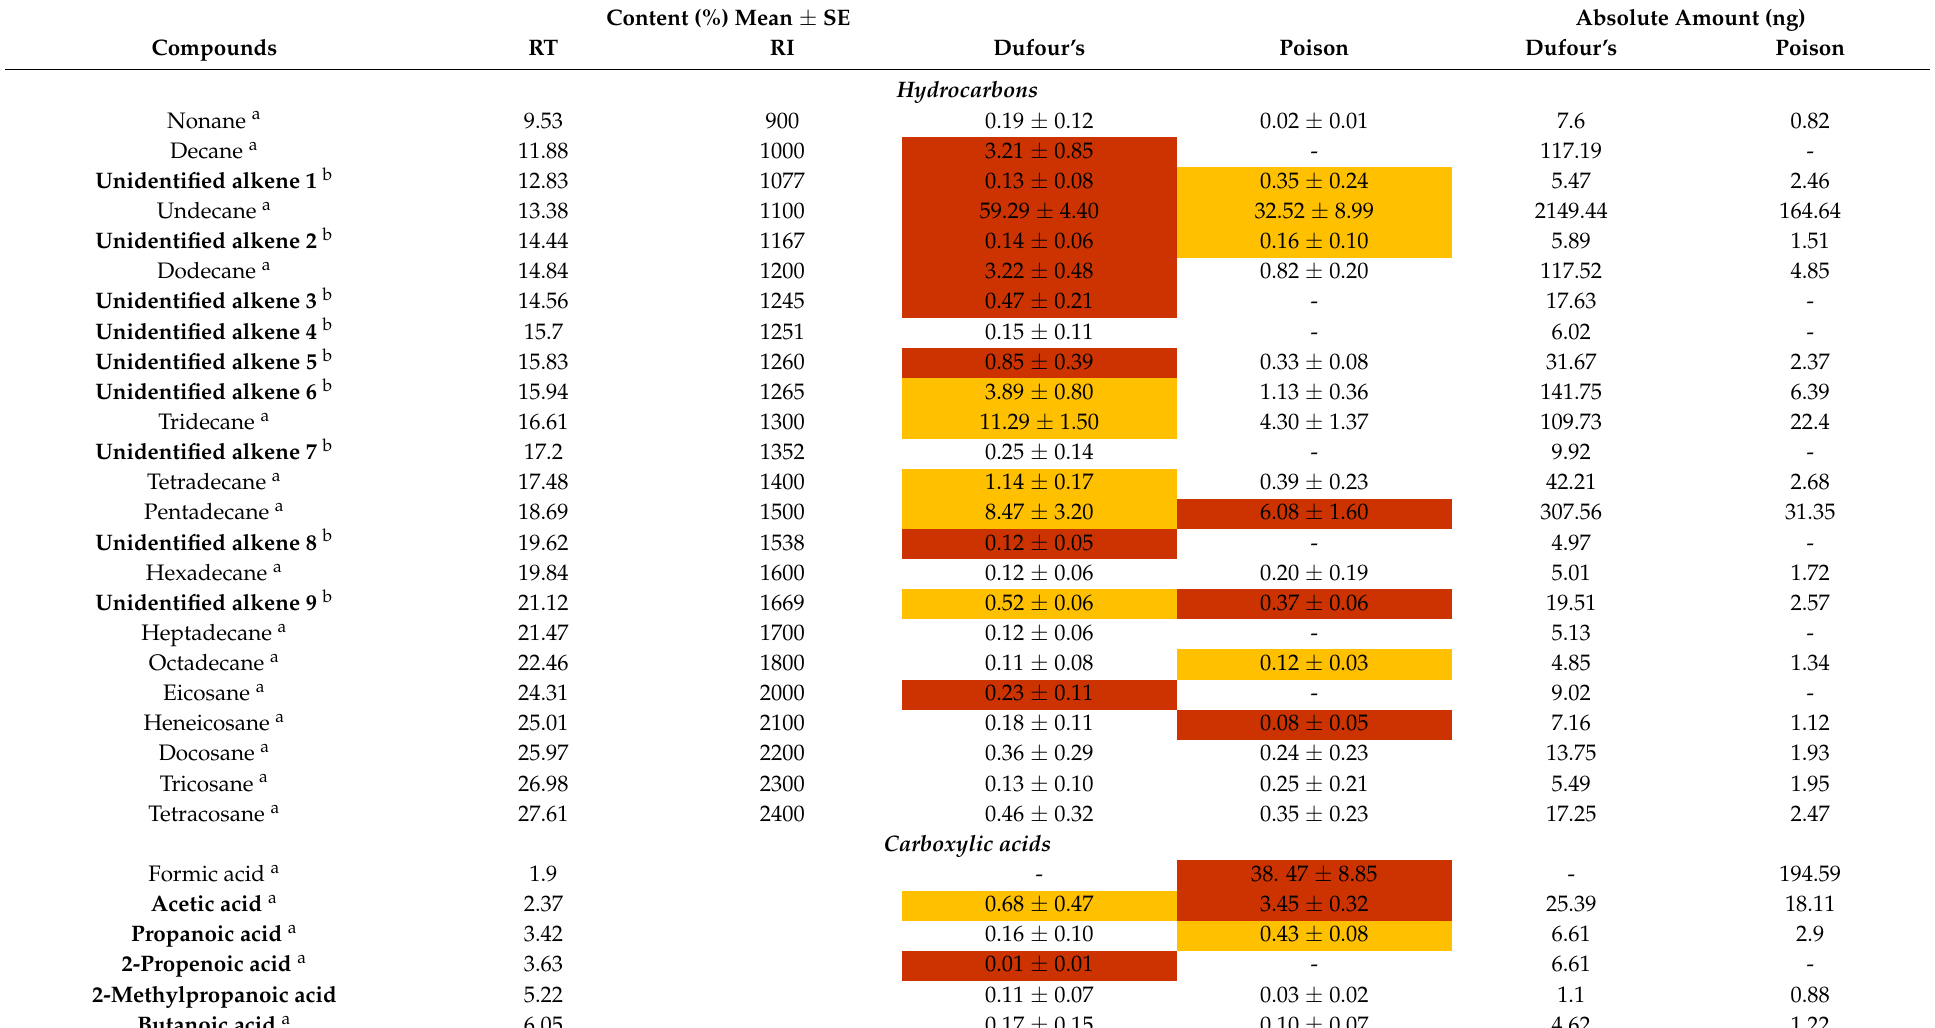
Table 2. Percentage compositions and amounts of headspace volatiles of Dufour’s and poison glands of major workers of O.